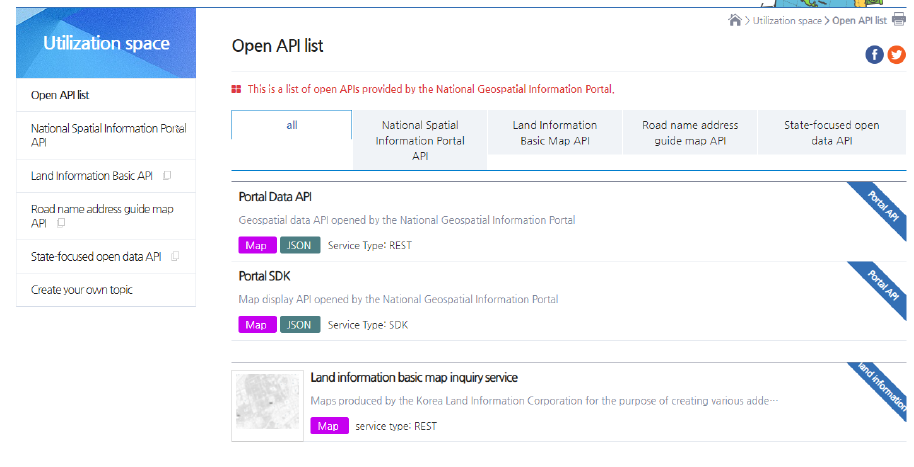
Figure 7. Open API of ‘utilization space’.